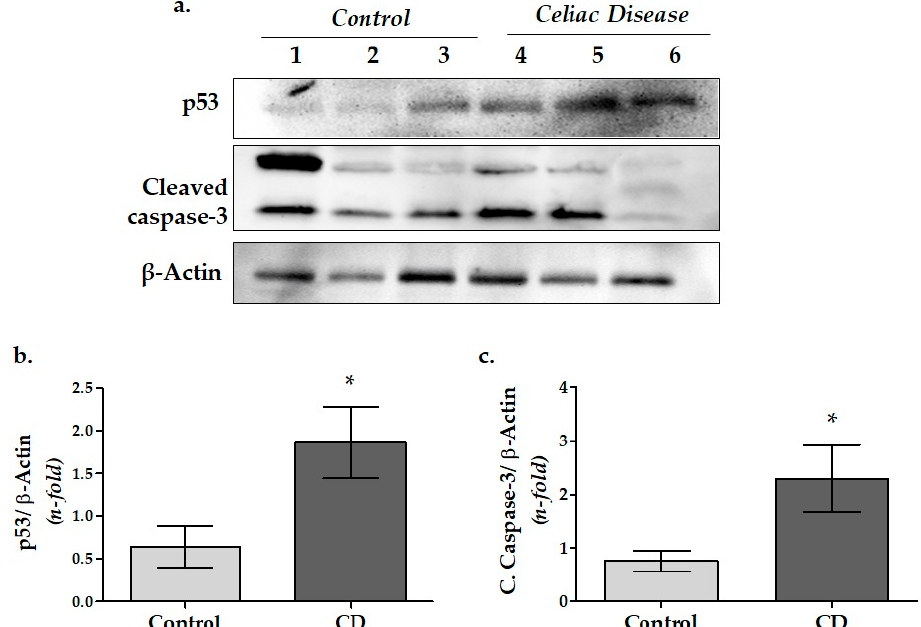
Figure 2. Apoptotic cell death-related cleaved caspase-3 and p53 protein expression levels in the duodenal tissue of pediatric CD patients. ( a ) Protein expression of cleaved caspase-3 and p53 were determined by WB analysis and quantified by densitometric analysis. Relative densitometric values of the ( b ) p53 protein expression and ( c ) cleaved caspase-3 protein expression levels. The β -actin signal was used to normalize the data, which were then expressed in arbitrary densitometric units. Data were expressed as mean ± SEM ( n = 3). * p < 0.05 versus the control group (CD: celiac disease